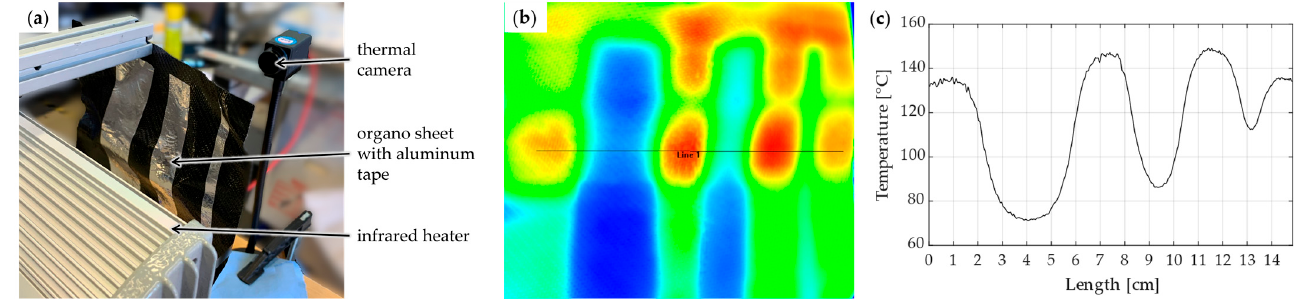
Figure 19. ( a ) Organo sheet with aluminum adhesive tape placed between an infrared heater and an infrared camera; ( b ) Infrared image of the heated organo sheet; ( c ) Temperature distribution along the line indicated in ( b ).